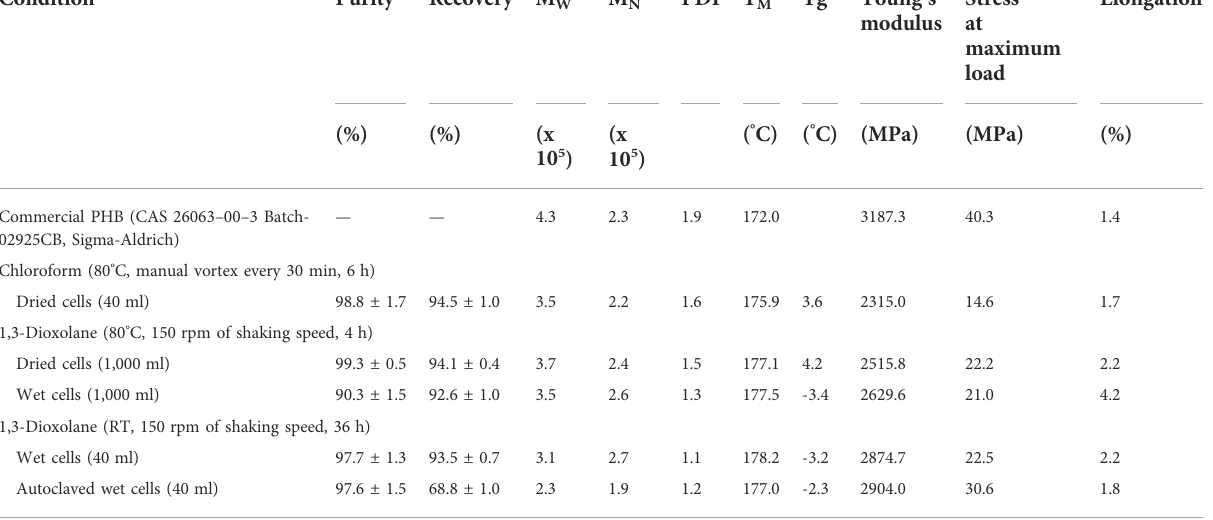
TABLE 4 Effect of 1,3-dioxolane extraction on the molecular weight distribution and thermal and mechanical properties.